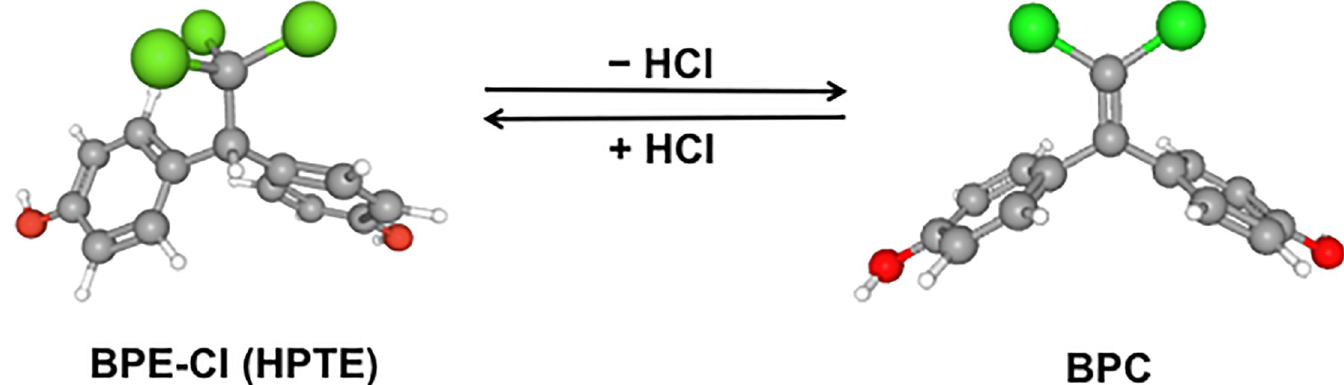
Fig 6. Dehydrochlorination (–HCl) and hydrochlorination (+ HCl) between BPC and BPE-Cl (HPTE). This chemical reaction formula is shown only for form’s sake. Synthesis of BPC by the dehydrochlorination of BPE-Cl (HPTE) was described by Cleveland et al. [39]. Ball and stick models are shown. The 3D-conformers of BPE-Cl [43] and BPC for this reaction formula were obtained from the chemical information resource PubChem [35].